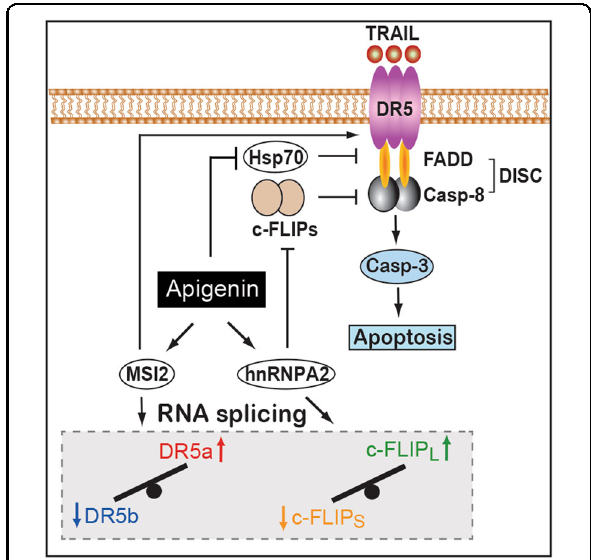
Fig. 6 Mechanisms responsible for apigenin-mediated TRAIL sensitization in lung cancer cells. TRAIL signals through the receptor DR5 to activate the DISC (FADD and Casp-8), which culminates in apoptosis. Hsp70 and c-FLIP S inhibit the DISC to block apoptosis. Apigenin reprograms the splicing of DR5 and c-FLIP through MSI2 and hnRPNA2, respectively, resulting in a shift in the predominant isoforms; these shifts impact receptor availability and DISC inhibition, respectively. Further, apigenin directly inhibits Hsp70 as well. Thus, apigenin enables TRAIL-induced apoptosis in lung cancer